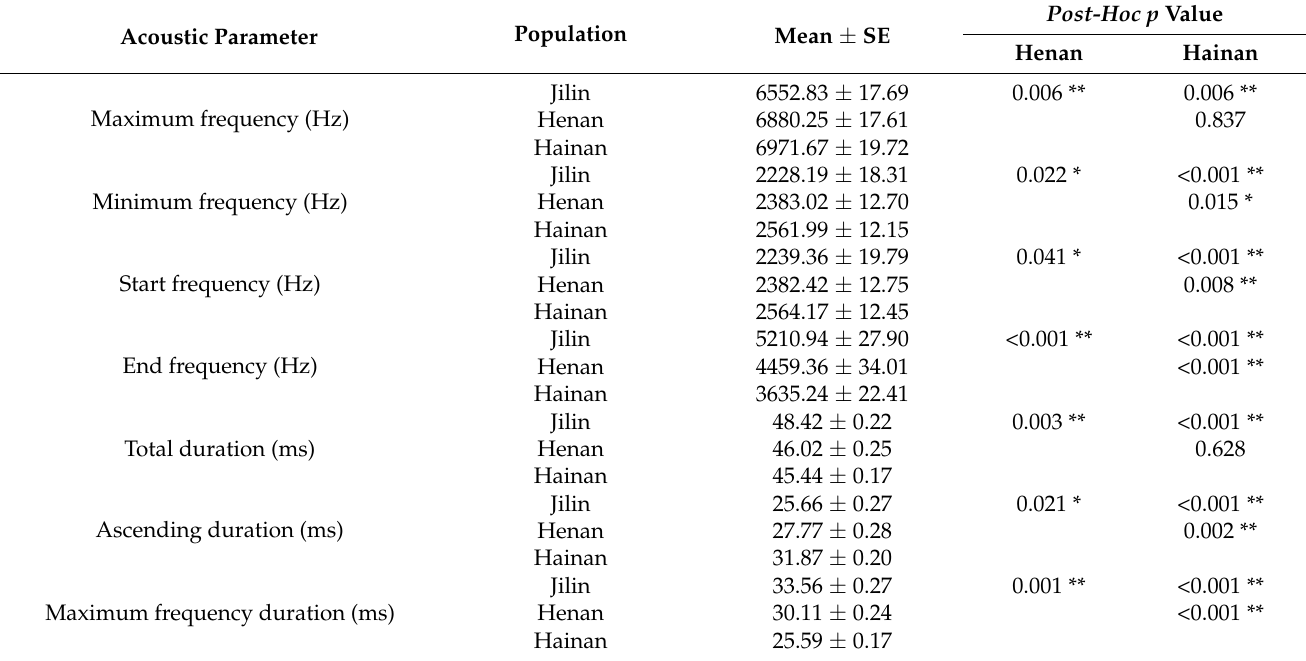
Table 3. The results of comparisons of the acoustic parameters of B notes in the alarm calls of Japanese